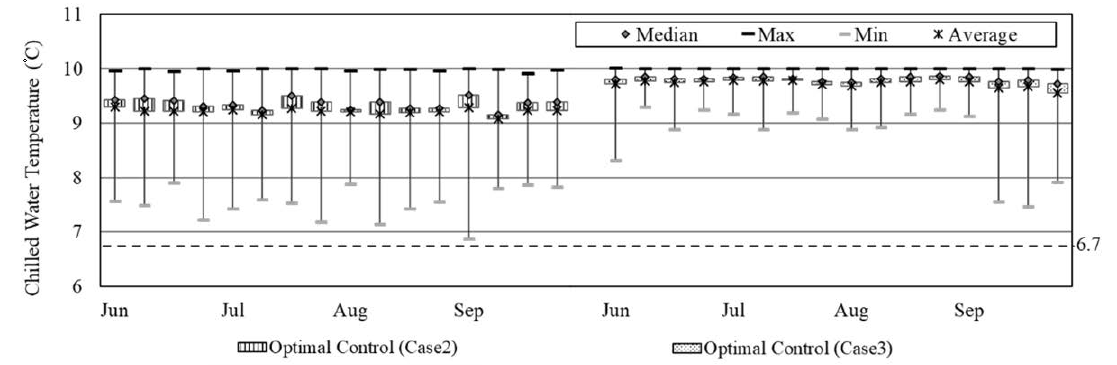
Figure 6. Chilled water temperature changes during optimal control mode for June through September.